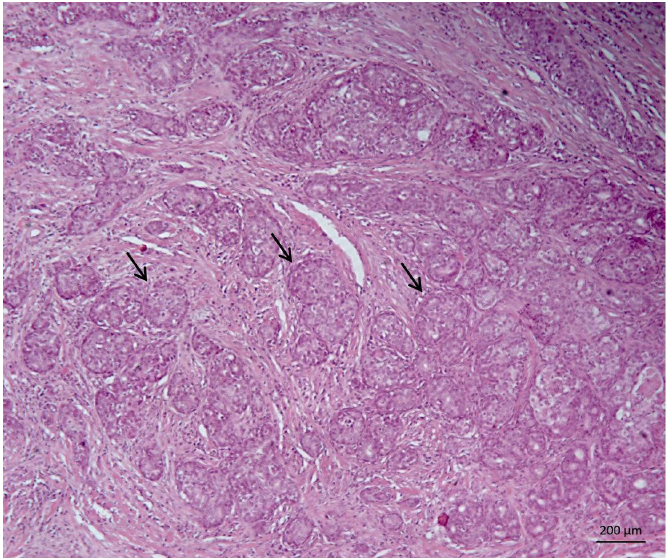
Figure 3. Proliferation of malignant neoplastic cells of epithelial origin in cluster arrangement separated by moderate fibrous stroma, H&E, 10×.